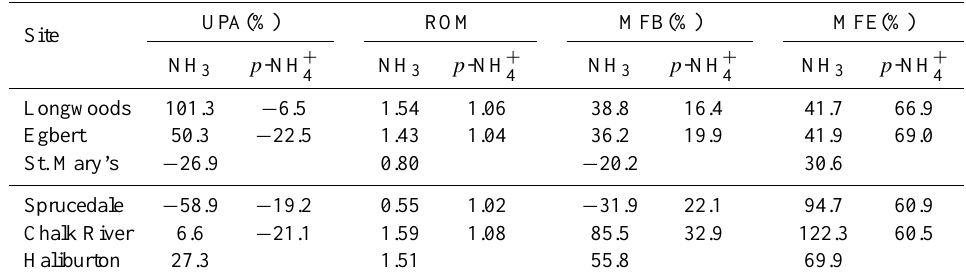
Table 3. Statistic for predicted NH 3 and p -NH +